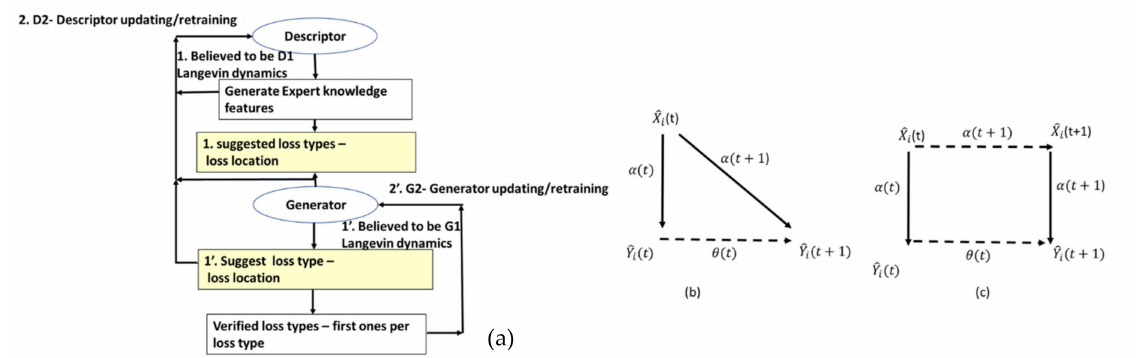
Figure 18. ( a ) Flowchart of cooperative training performed by the discriminator and generator over the same self-generated dataset. ( b ) The teaching procedure of TNT loss follows the MCMC teaching procedure probabilistically, although no Markov chain and no Monte Carlo are intentionally constructed. ( c ) A more elaborate Markov chain describes the same cooperative